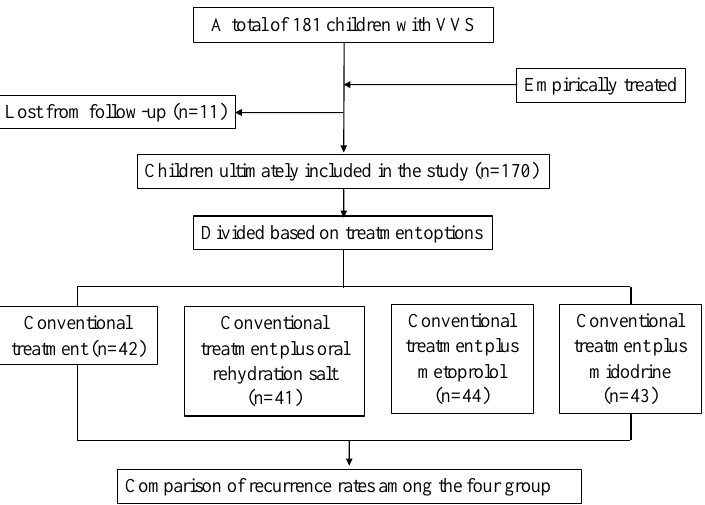
Figure 1. Flowchart of children with vasovagal syncope. VVS: vasovagal syncope.